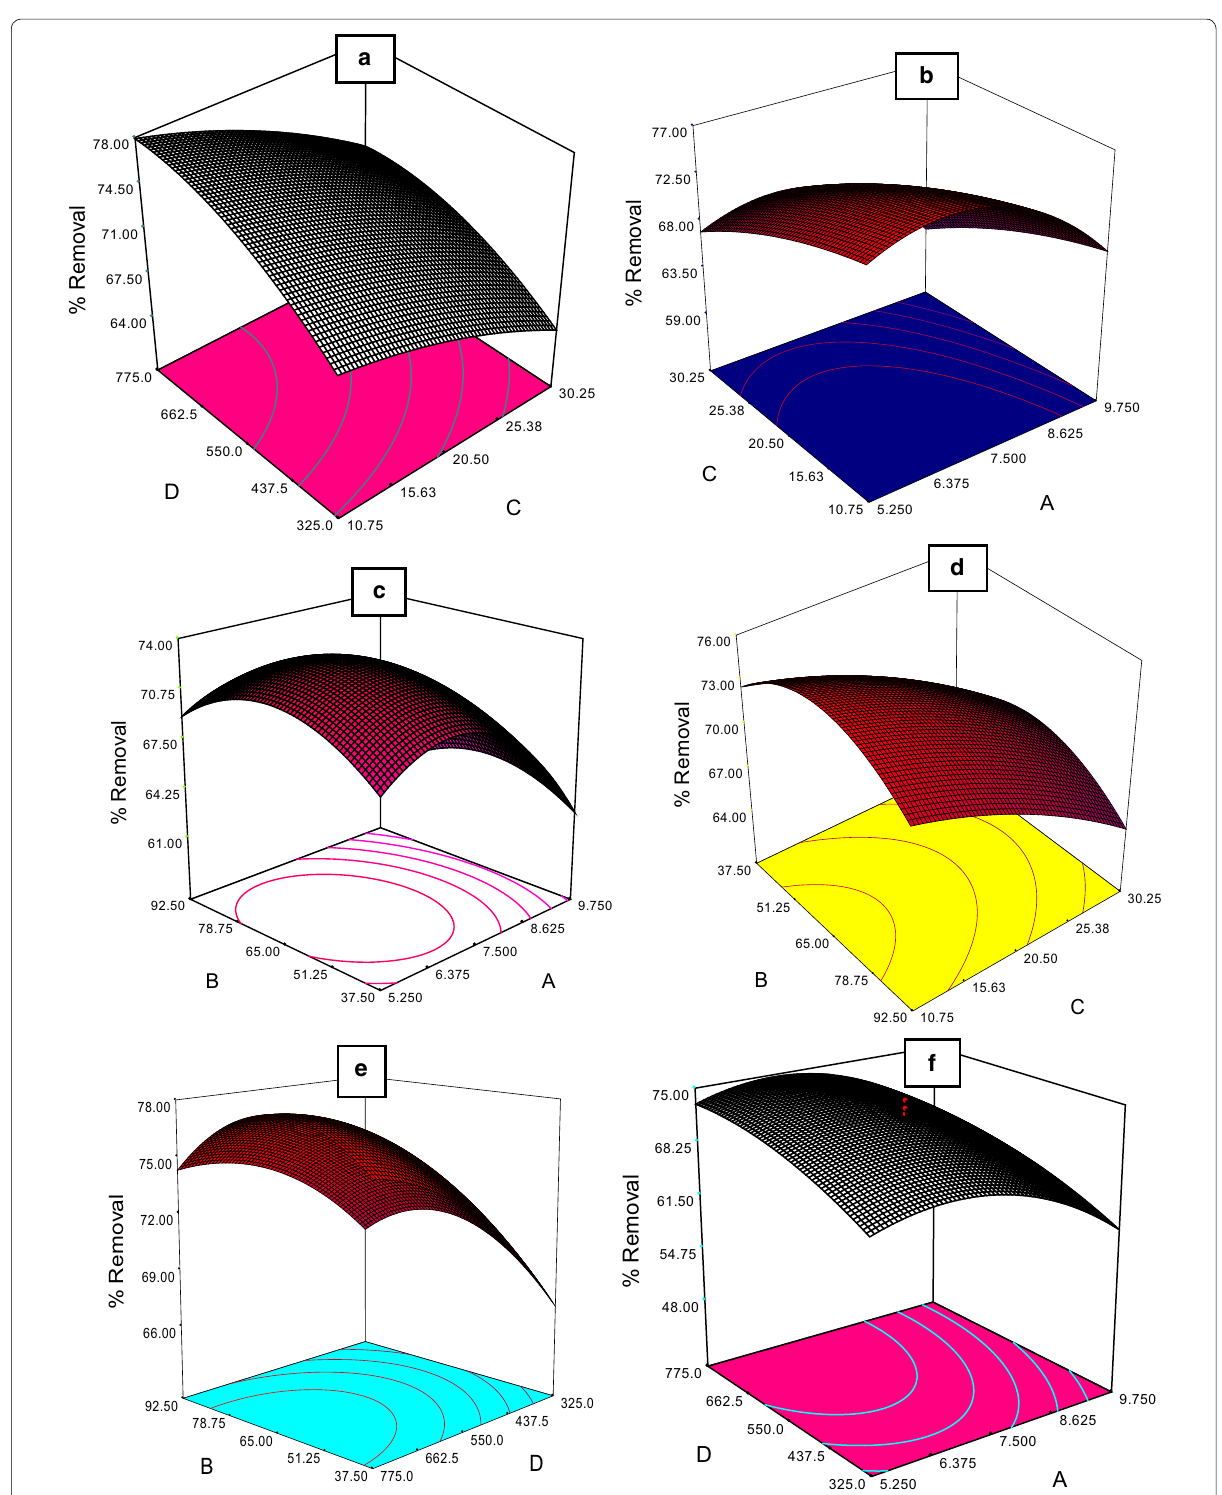
Fig. 3 Three-dimensional response removal of acetamiprid with interactions between factors. a The effect of dose of nanoparticles (mg/L) and concentrations of acetamiprid (mg/L). b The effect of concentrations of acetamiprid (mg/L) and pH. c The effect of contact time (min) and pH. d The effect of contact time (min) and concentrations of acetamiprid (mg/L). e The effect of contact time (min) and dose of nanoparticles (mg/L). f The effect of dose of nanoparticles (mg/L) and